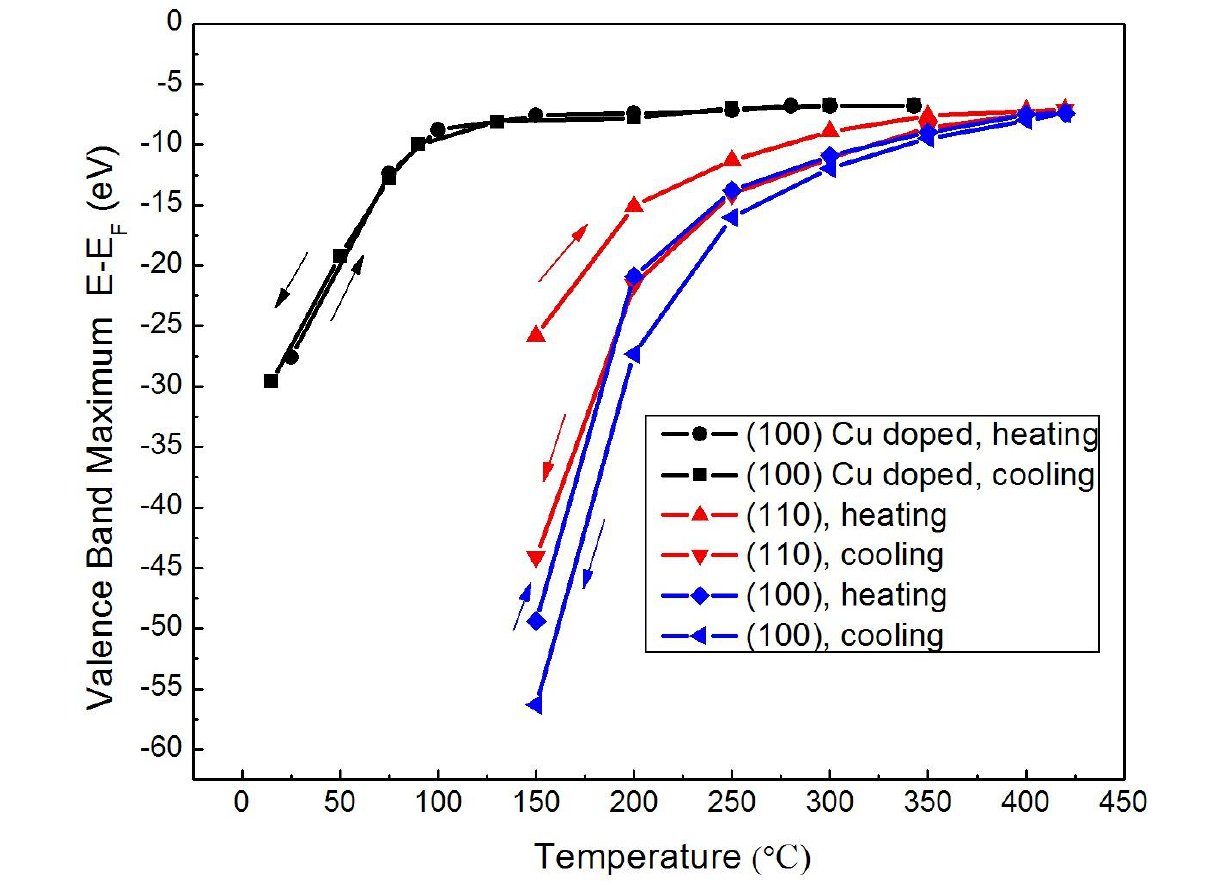
B O (110) (red), Li 2 4 7 Cu B O (100) (black) as measured from the 1.998 0.002 4 7